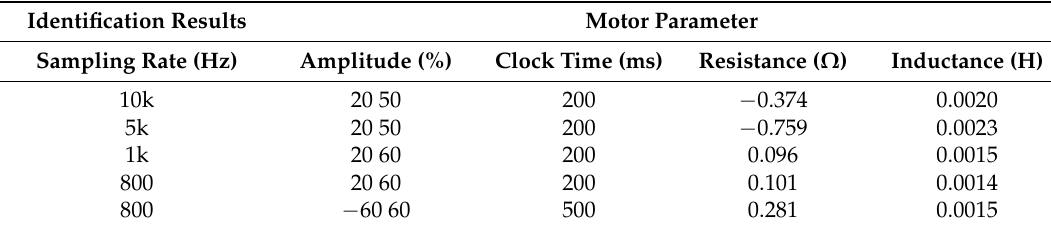
Figure 6. Step response for identifying the motor model at different sampling rates. Table 3. Identification of the motor parameters under different identification conditions.